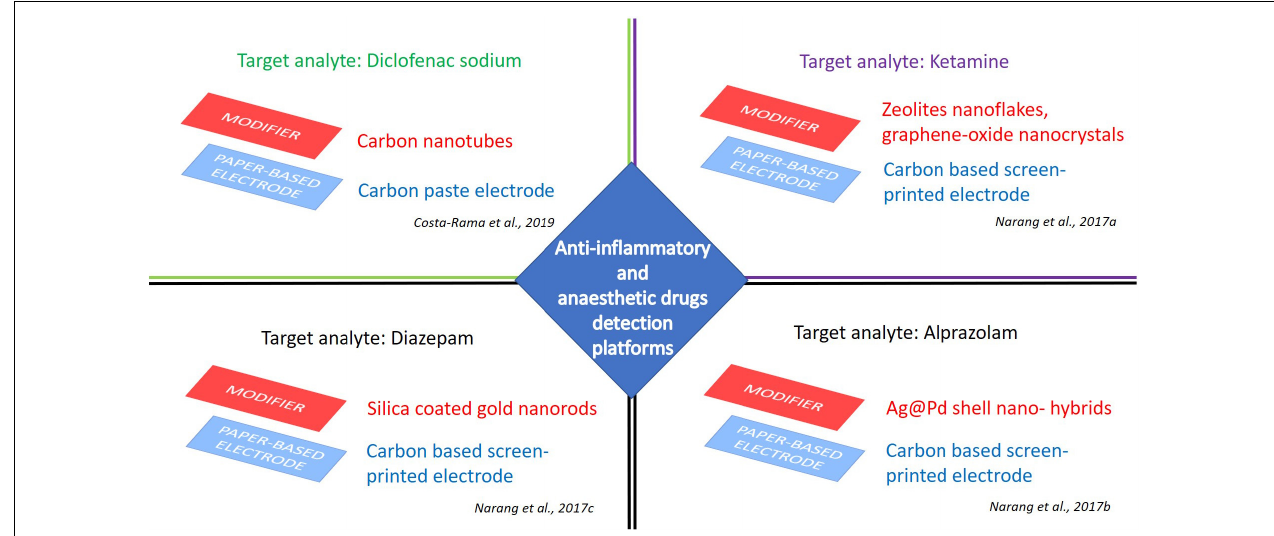
FIGURE 4 | e-PAD platforms for detection of anti-inflammatory and anesthetic drugs. Target analytes: Diclofenac sodium (Costa-Rama et al., 2019), ketamine (Narang et al., 2017a), alprazolam (Narang et al., 2017b), and diazepam (Narang et al., 2017c).